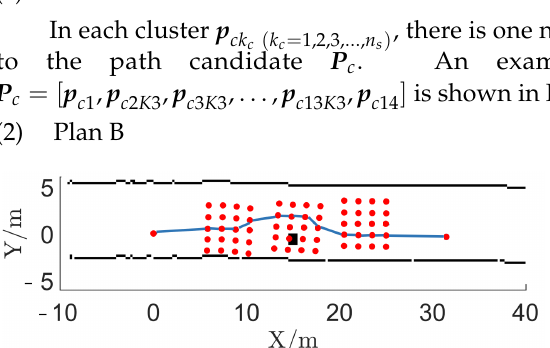
Figure 9. An example of